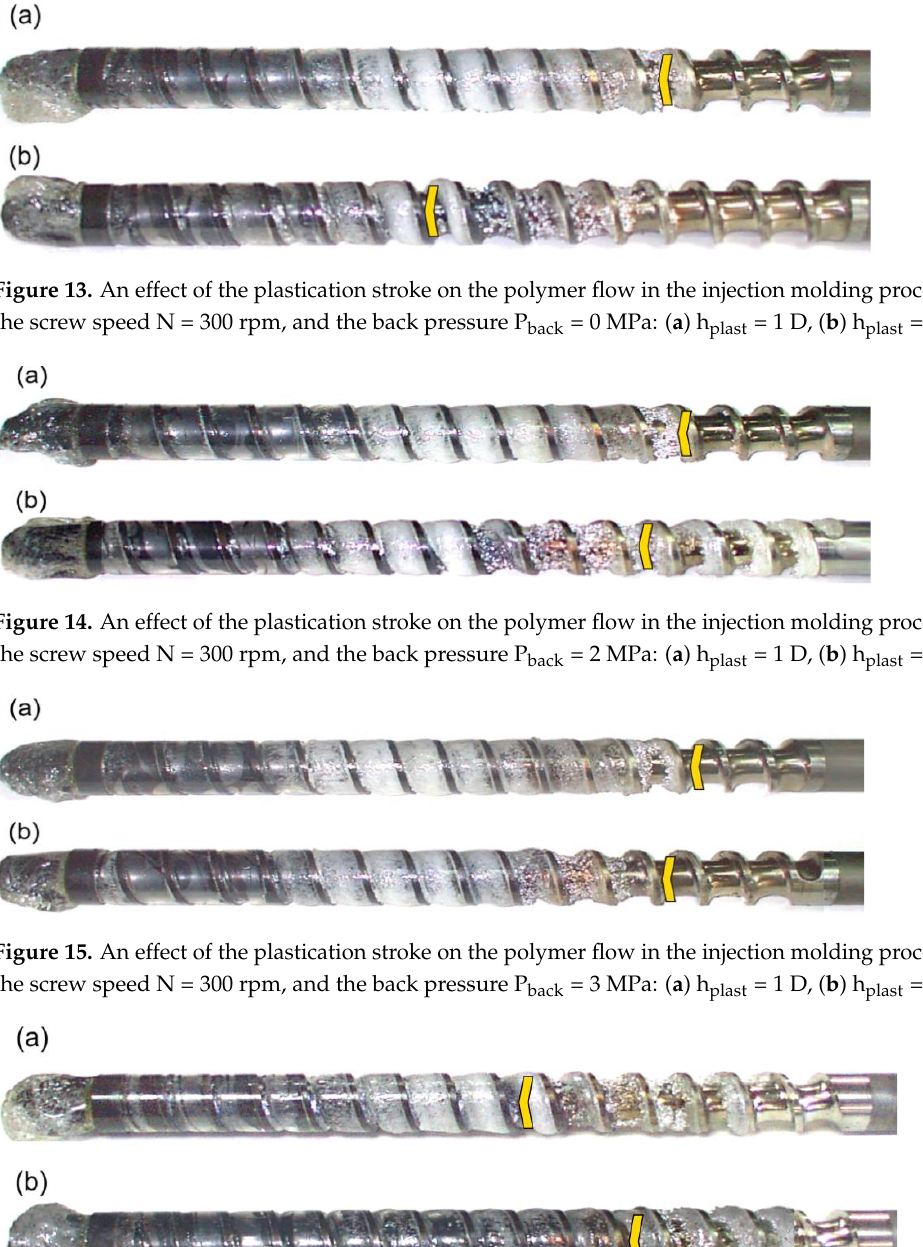
Figure 16. An effect of the back pressure on the polymer flow in the injection molding process at the screw speed N = 100 rpm, and the plasticating stroke h plast = 1 D: ( a ) P back = 0 MPa, ( b ) P back = 2 MPa.